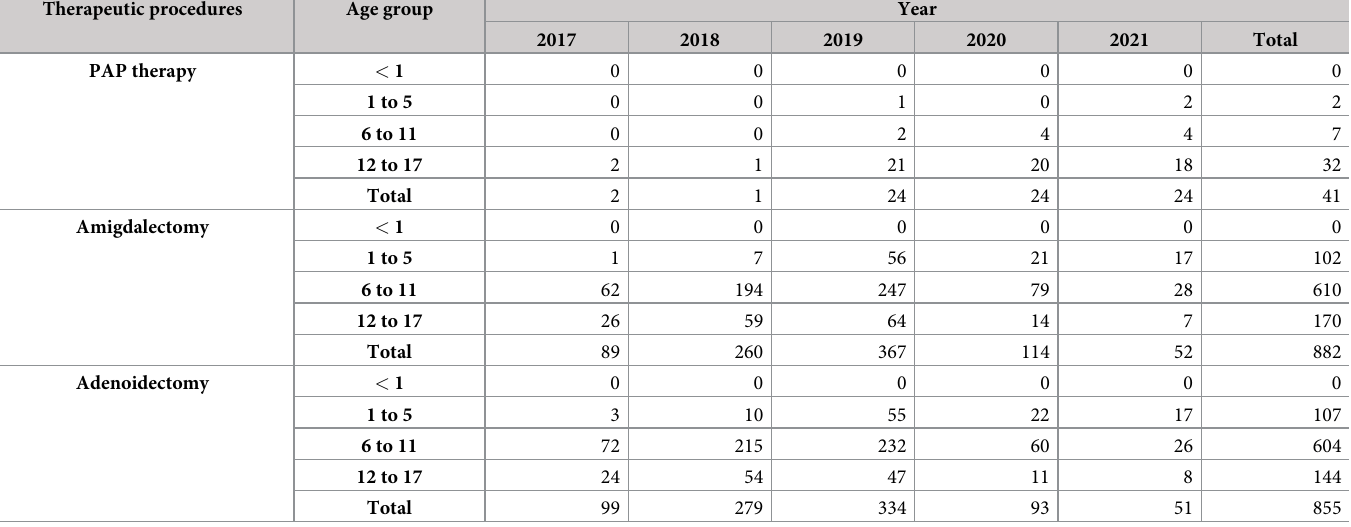
Table 5. Diagnostic procedures performed in children and adolescents with sleep apnea, Colombia